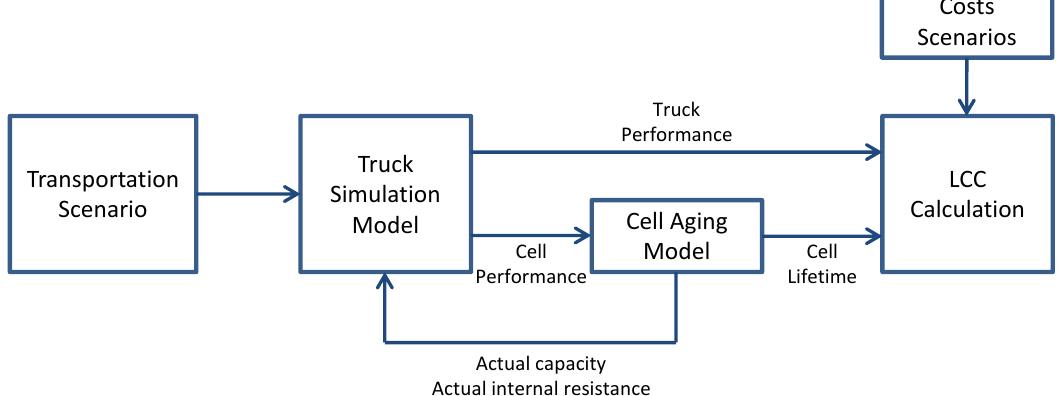
Figure 9. Data required for the calculation of life cycle costs of a truck.